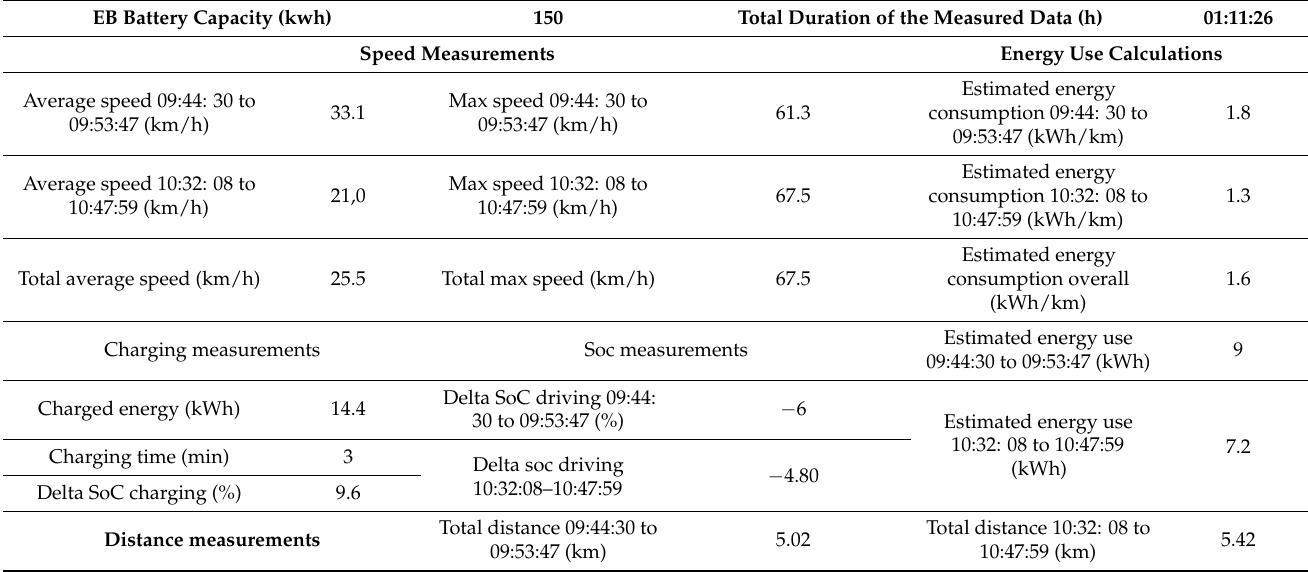
Table 6. Aggregated data from the IRIZAR EB in